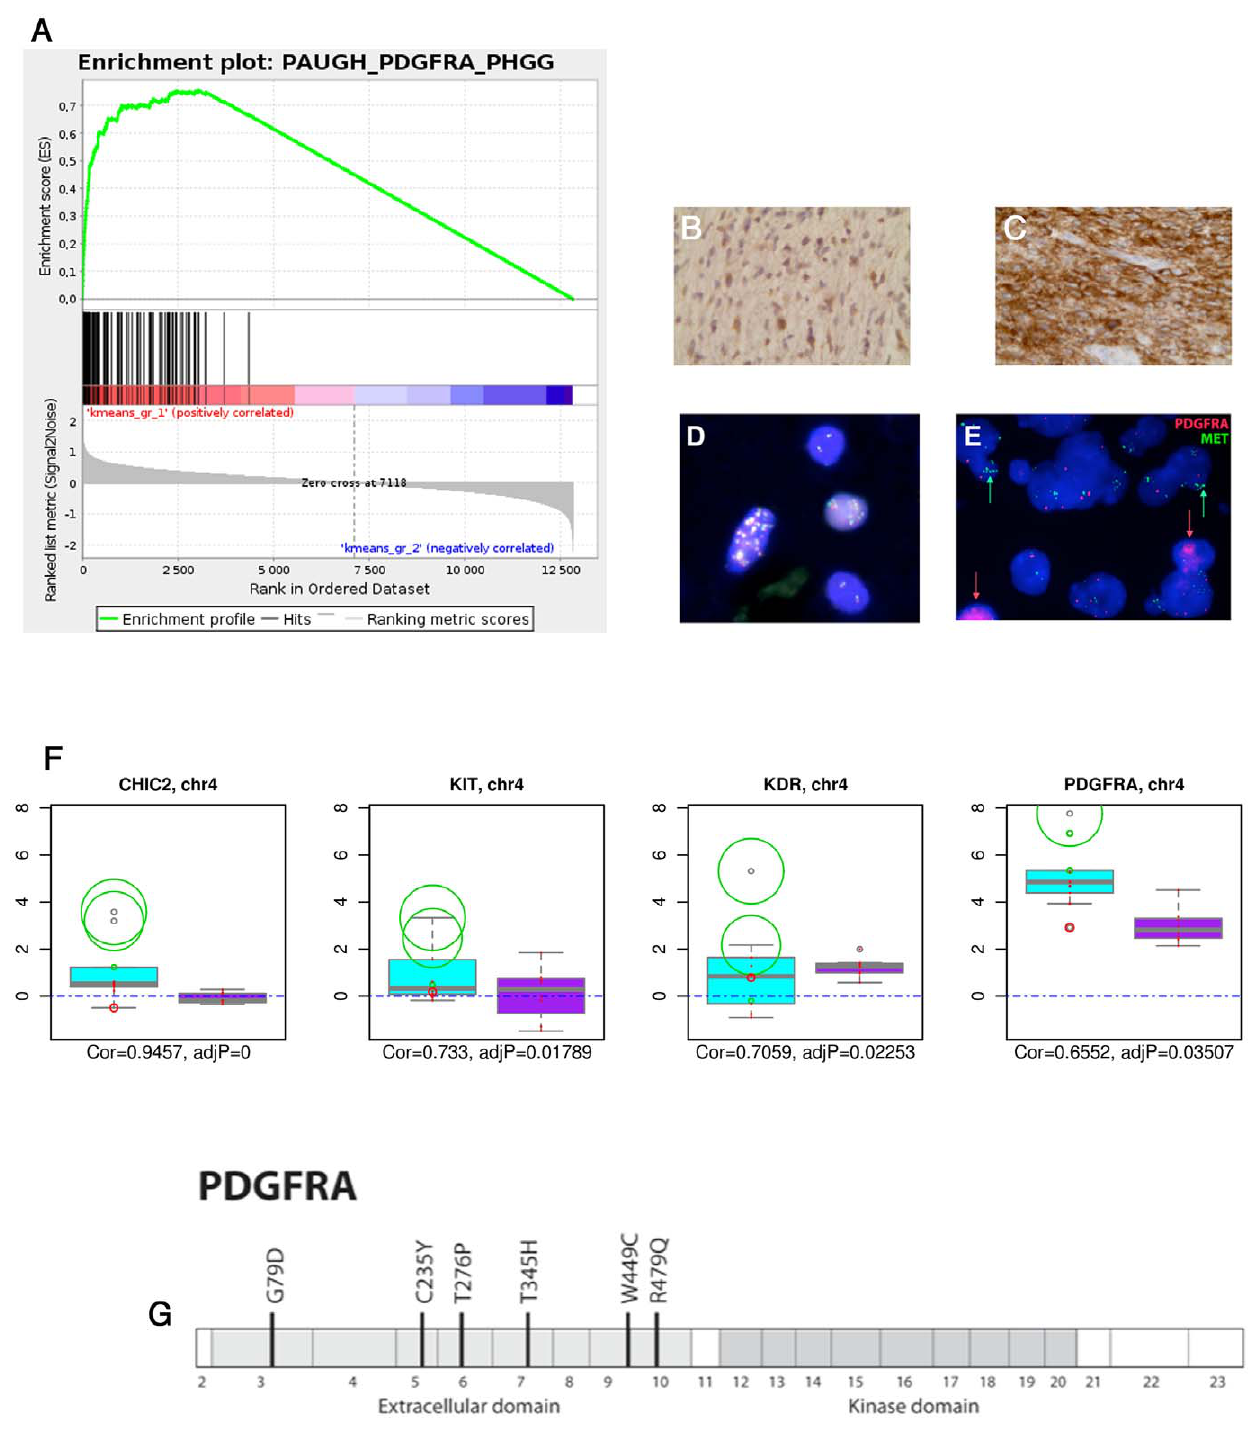
Figure 5. PDGFRA amplification/mutation is driving the oncogenesis of the oligodendroglial/proneural type of DIPG. Panel A: GSEA graph showing the enrichment of group 1 DIPG for the gene set describing the gene expression profile of PDGFRA amplified glioblastomas. Panel B: PDGFRA immunohistochemistry in the infiltrative part of a DIPG. Panel C: PDGFRA immunohistochemistry in the tumoral part of a DIPG. Panel D: FISH analysis of a DIPG using a FIP1L1/PDGFRA probe showing the amplification of the locus encompassing the two genes (most frequently seen). Panel E: Dual-FISH analysis of a DIPG with two probes one for PDGFRA and one for MET showing that the two oncogenes may be gained/amplified in different cells within the tumor. Panel F: Integrative genomic analysis using DR-Integrator (R package). Seven genes are present in the minimal common region (MCR) gained on chromosomal location 4q12 in DIPG. Boxplots represent the distribution of GE data and circles represent CNA data. The circles are centered on the corresponding GE measure on the distribution and their radii are proportional to the absolute value of CNA, red ones being losses and green ones gains. CNA and GE were highly correlated for four of these seven genes ( CHIC2, KIT, KDR, PDGFRA ). Panel G: Diagram of the PDGFRA gene showing the mutations discovered in DIPG samples and xenografts.